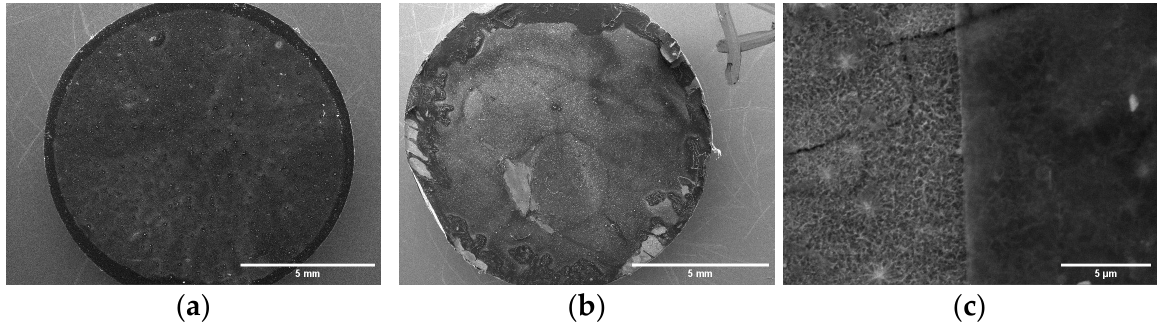
Figure 11. SEM images of TTNT + MNZ + 1PVA group, ( a ) before and ( b , c ) after “in vitro” MNZ release assay.